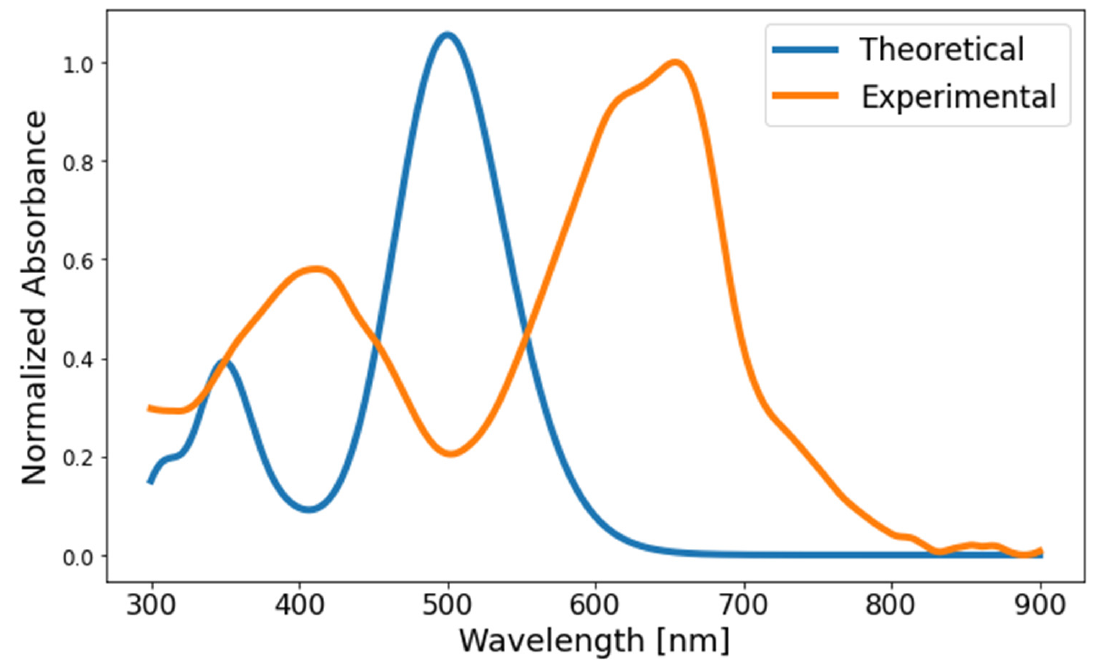
Figure 15. Theoretical and experimental UV–vis absorption spectra for the PFDPP polymer.